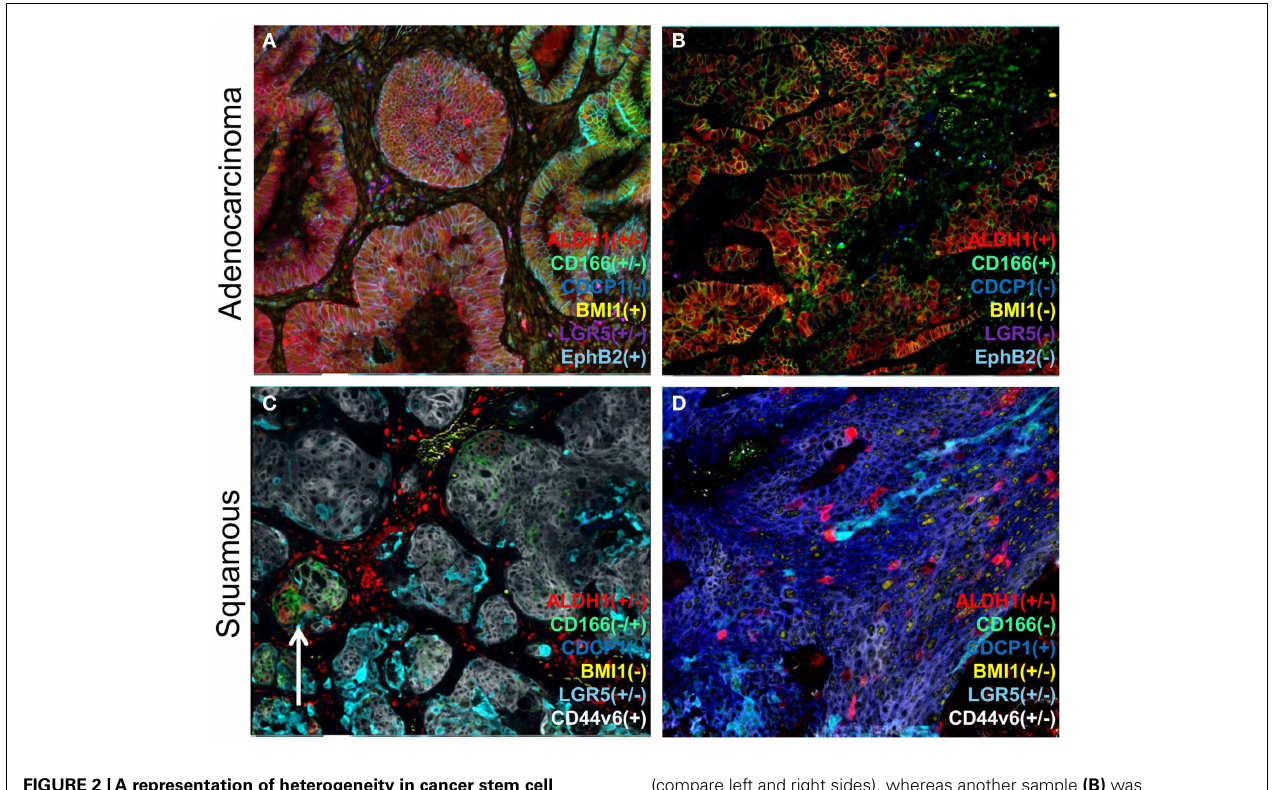
FIGURE 2 |A representation of heterogeneity in cancer stem cell marker expression . A series of lung cancers were examined for the expression of various reported cancer stem cell markers using a multiplexed protocol on the MultiOmyx™ platform to illustrate the heterogeneity in cancer stem cell protein markers. Examples of adenocarcinoma (A,B) show two different cellular profiles with the sample on the left (A) displaying intratumoral heterogeneity for ALDH1 and CD166